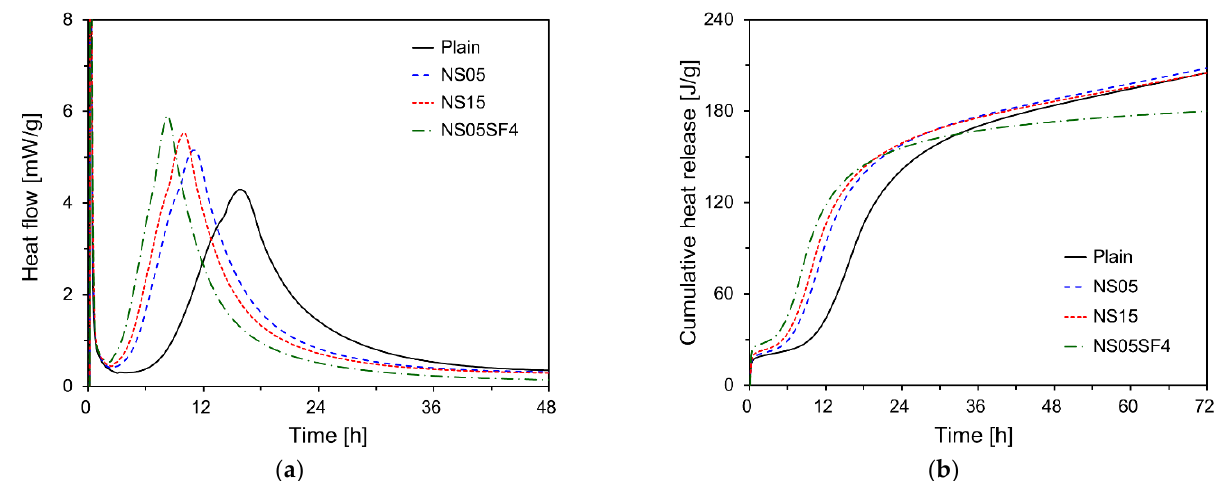
Figure 6. ( a ) Hydration heat flow and ( b ) cumulative heat release.